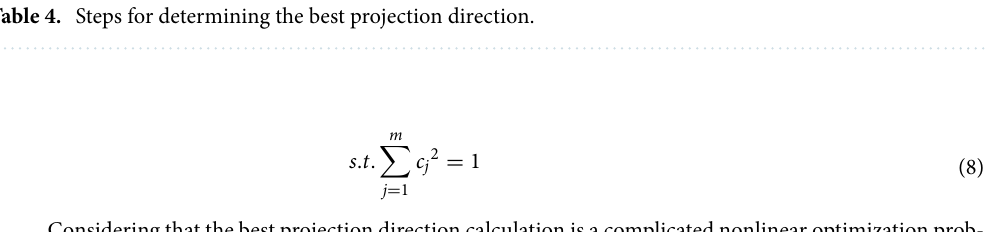
Table 4. Steps for determining the best projection